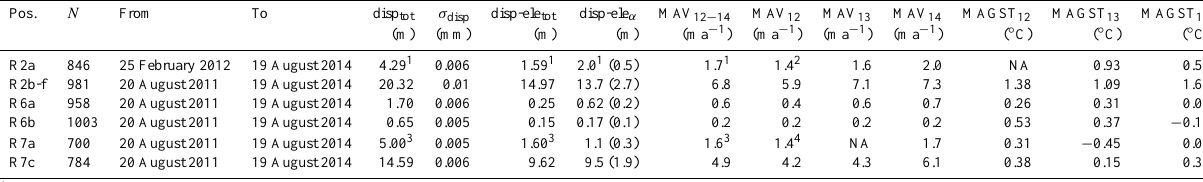
Table 4. Characteristics of individual GPS stations. N : number of daily GPS solutions obtained; from and to: measurement period; disp tot : total displacement; σ disp : standard deviation of total displacement (estimated based on 2000 Monte Carlo simulations); disp-ele tot : total vertical displacement; disp-ele α : vertical displacement related to surface slope angle with related uncertainties from 5 ◦ variations in surface slope ; MAV 12 − 14 : mean velocity for the entire measurement period; MAV 12 , MAV 13 , and MAV 14 : mean annual velocities. Note that for R2a only GPS measurements since 23 February 2012 exist and, thus, results for MAV 12 − 14 and especially R2a results for MAV 12 may not be fully representative of the “true” displacement for the period 2011/12. For R7a, there is a data gap from summer 2012 to spring 2013. Pos.